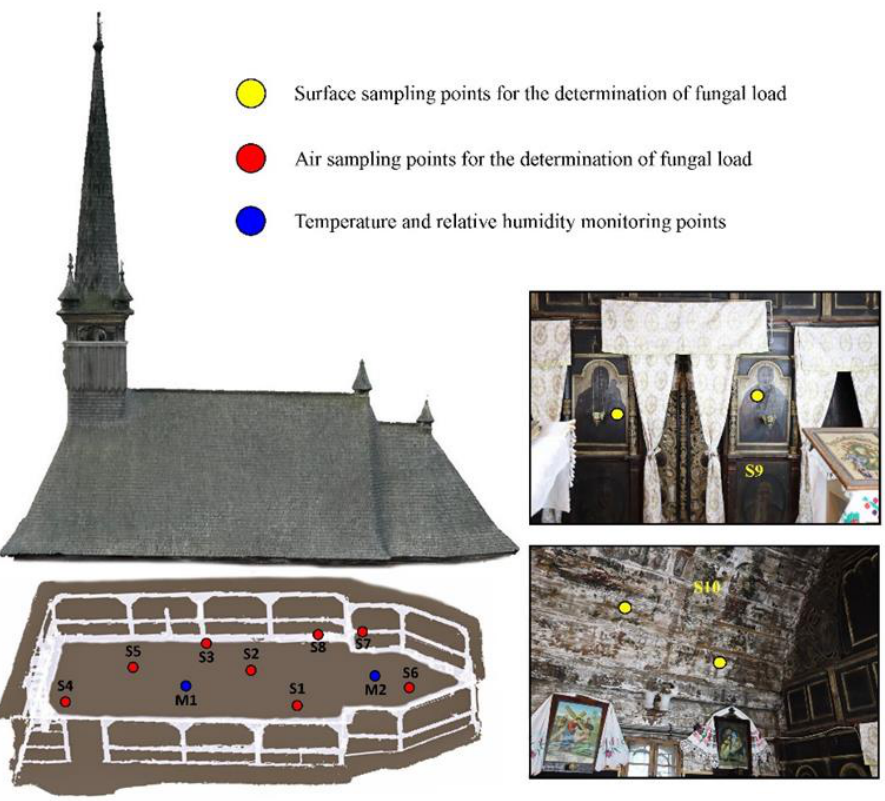
Figure 3. Spatial distribution of sampling points for the assessment of the fungal load and the location of the devices for determining the indoor microclimate .